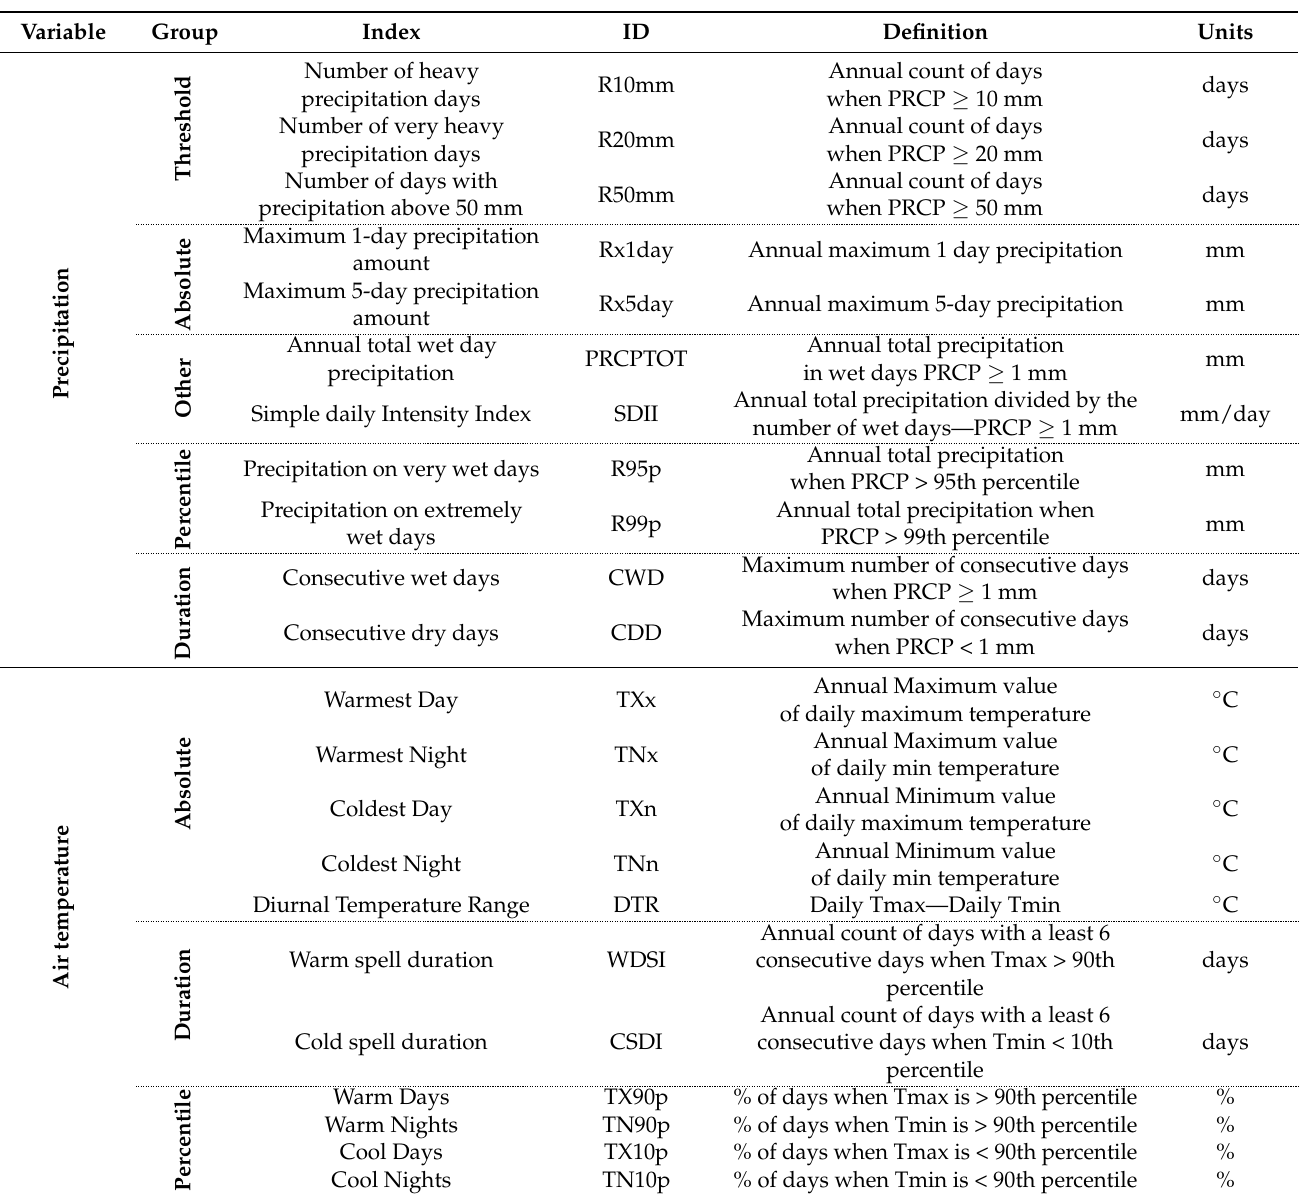
Table 2. Description of precipitation and air temperature climate extreme indices for the Brazilian Midwest. Tmax: Maximum Temperature; Tmin: Minimum Temperature; PRCP: Daily